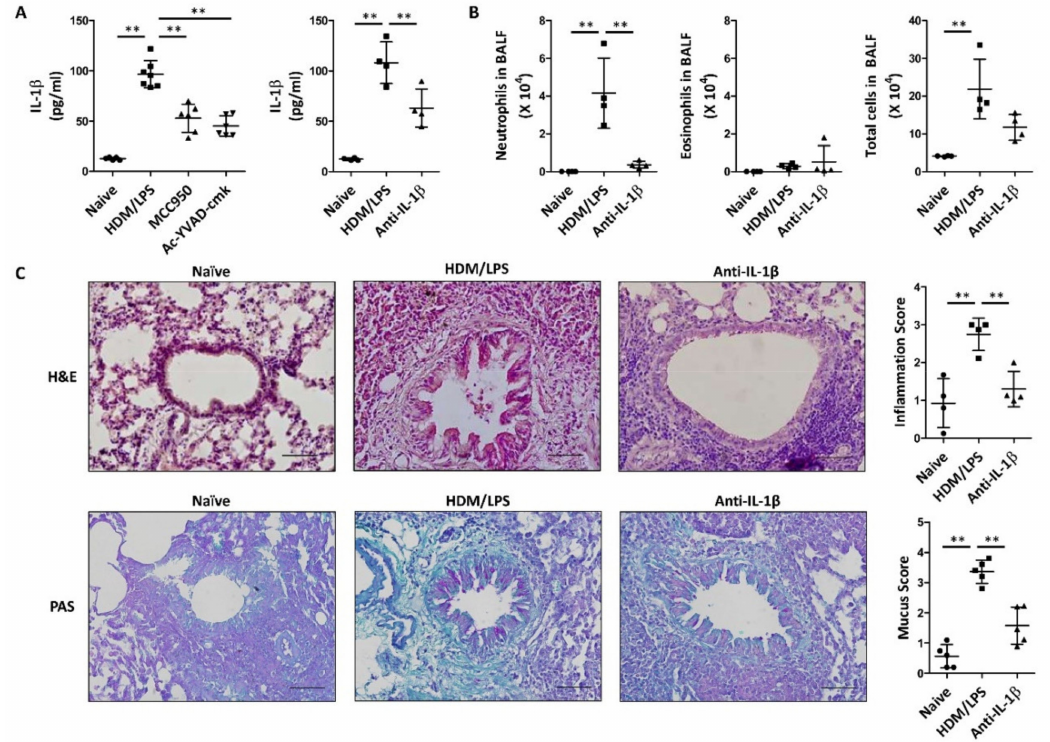
Figure 2. IL-1 β is produced via NLRP3 stimulation and is critical for the HDM/LPS-induced neutrophilic airway inflamma- tion. To analyze the effect of IL-1 β inhibition, mice were received with anti-IL-1 β antibody or control IgG1 (5 mg/kg) via i.p. injection 1 h before each challenge. Naïve designates control without any additions. ( A ) Levels of IL-1 β were analyzed in lung lysates using ELISA. Data are shown as the mean ± SD ( n = 4–7 per group). ( B ) The numbers of neutrophils and eosinophils as well as total immune cells were obtained in BALF using Cytospin and then stained with Diff-Quik. Data are shown as the mean ± SD ( n = 4 per group). ( C ) H&E and PAS staining were performed with the lungs that were excised and fixed. Perivascular and peribronchial lung inflammation were determined and scored (400 × ). Data are shown as the mean ± SD ( n = 4–5 per group). All experiments were performed in triplicate. ** p < 0.01 versus each control